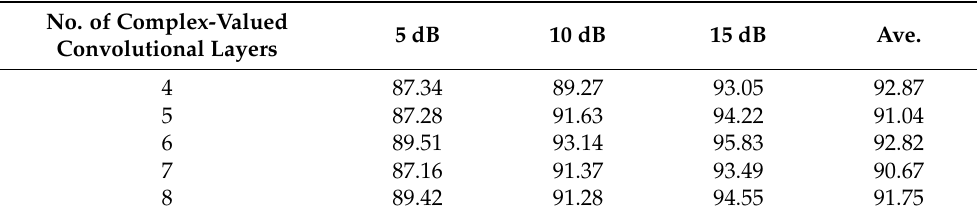
Table 6. The STOI (in %) scores for models with different complex-valued convolutional layers. No. of Complex-Valued Convolutional